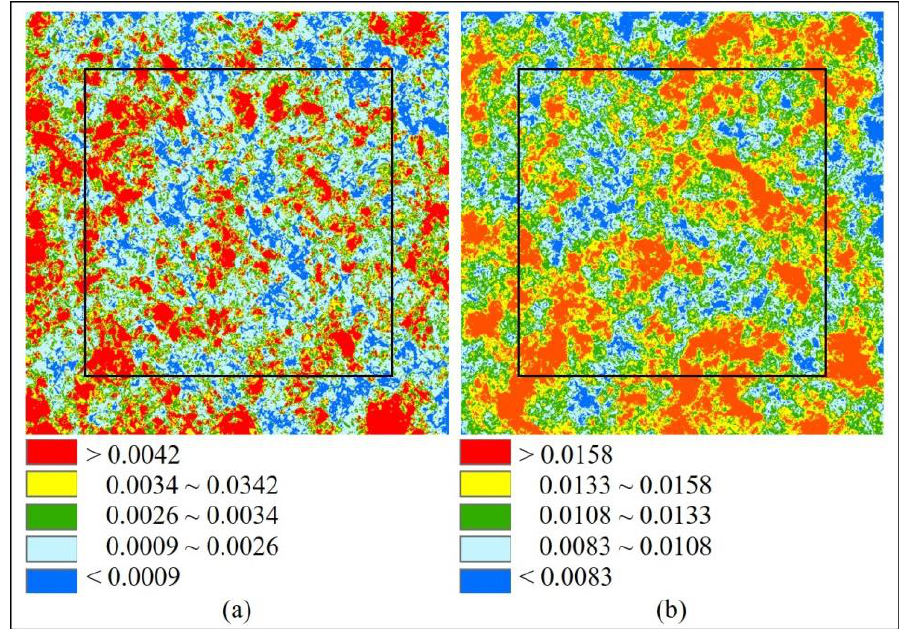
Figure 5. Grid-level fire frequency (GFF) maps for the 2900 × 2900 grid landscape using ( a ) 1000 fire-year maps (GFF 1000 ) and ( b ), and 1200 fire-year maps (GFF 1200 ). While (a) employed none of the Class 1 fire-year maps, (b) employed all 200 of the Class 1 fire-year maps. The grid value is the FF in fires per year; di ff erent scales are used for the two GFF maps, due to di ff erent mean FFs. The inner black line is a 40 km buffer.